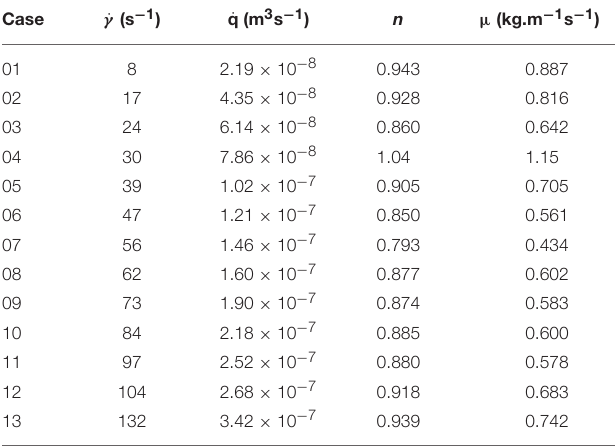
TABLE 1 | Shear rate, flow rate, power law index, and viscosity for each